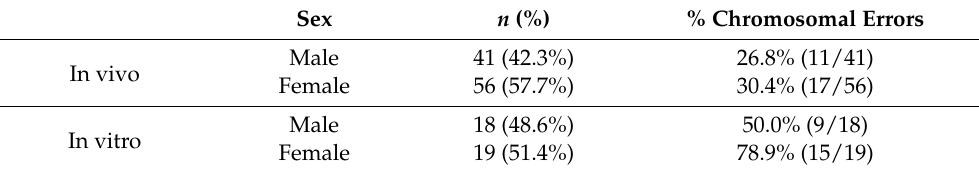
Table 4. Sex ratio and incidence of chromosomal errors for in vivo and in vitro embryos.